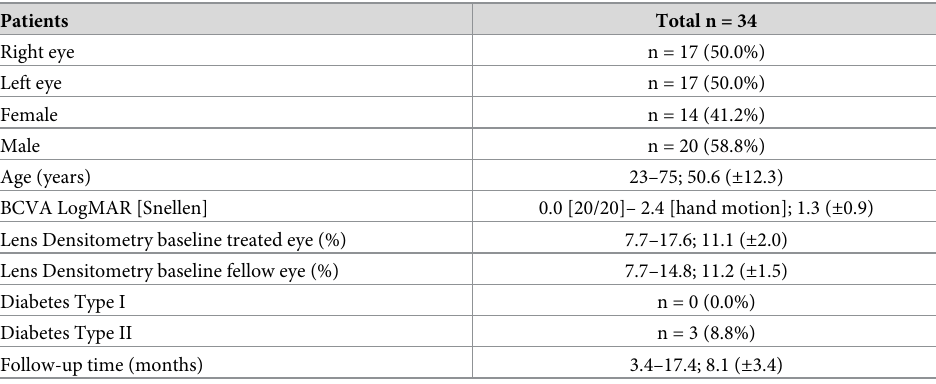
Table 1. Demographics and preoperative